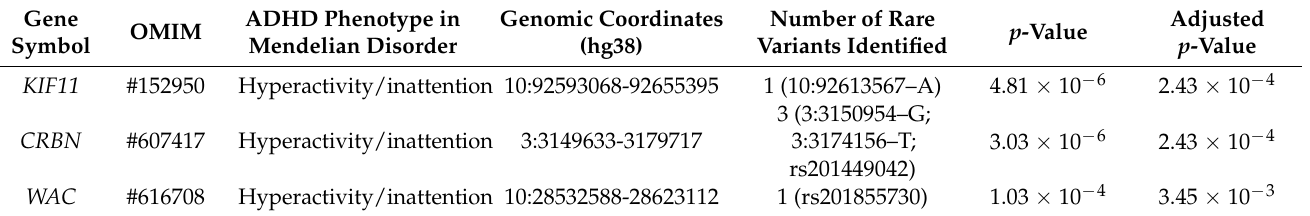
Table 1. Genes associated with the inattention symptom dimension in the rare variants analysis from the OMIM gene list (autosomal).